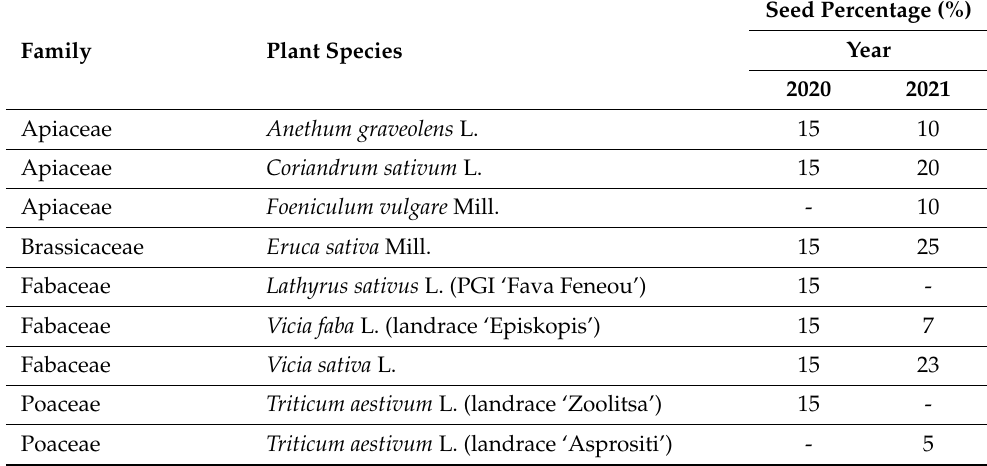
Table 1. Selected plant species used in sown seed mixtures in patches at the groundcover of apple orchards and seed percentage of each species in the two experimental